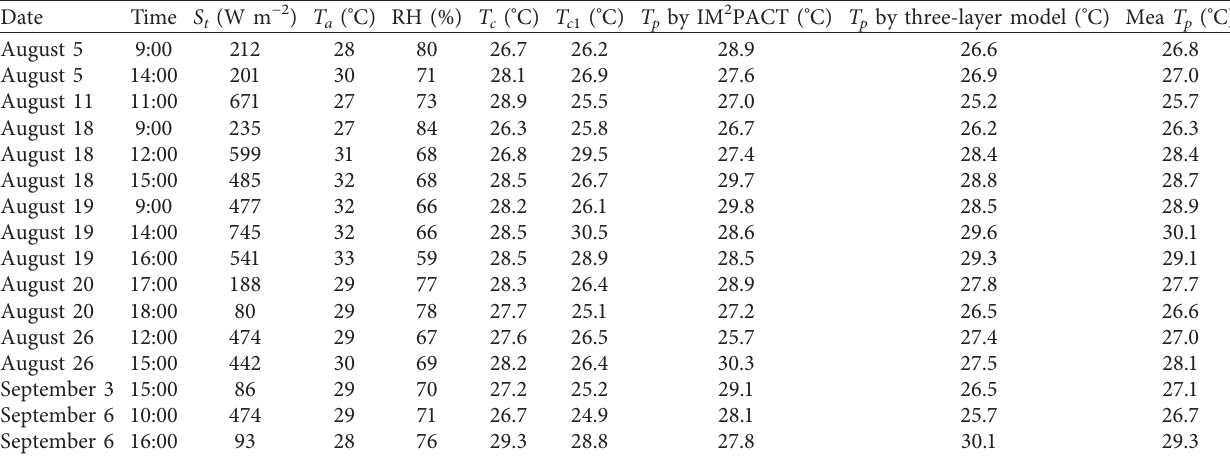
Table 5: T p estimated by three-layer model and by IM